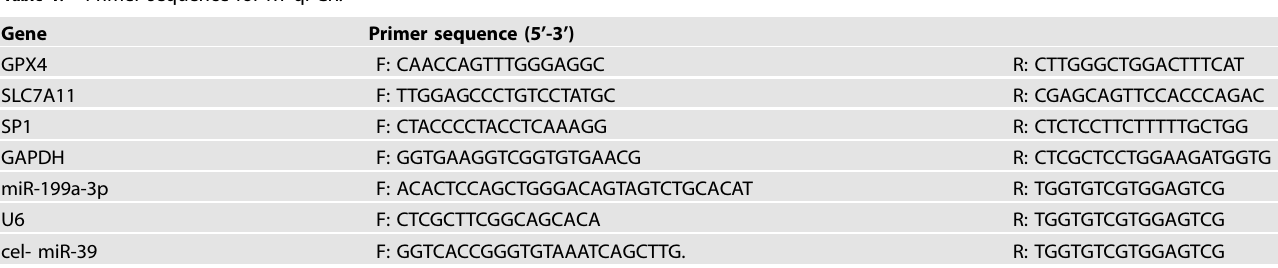
Table 1. Primer sequence for